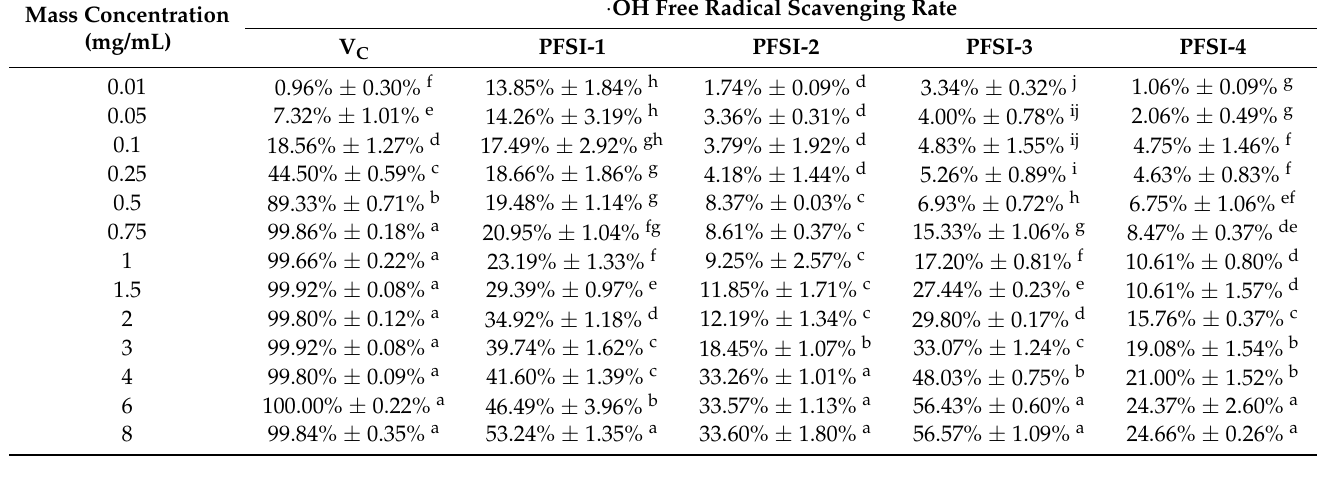
Table 5. · OH free radical scavenging by PFSI-1, PFSI-2, PFSI-3, and PFSI-4. (Note: same lowercase let- ters indicate no significant difference between groups, different lowercase letters indicate a significant difference between groups, p < 0.05).